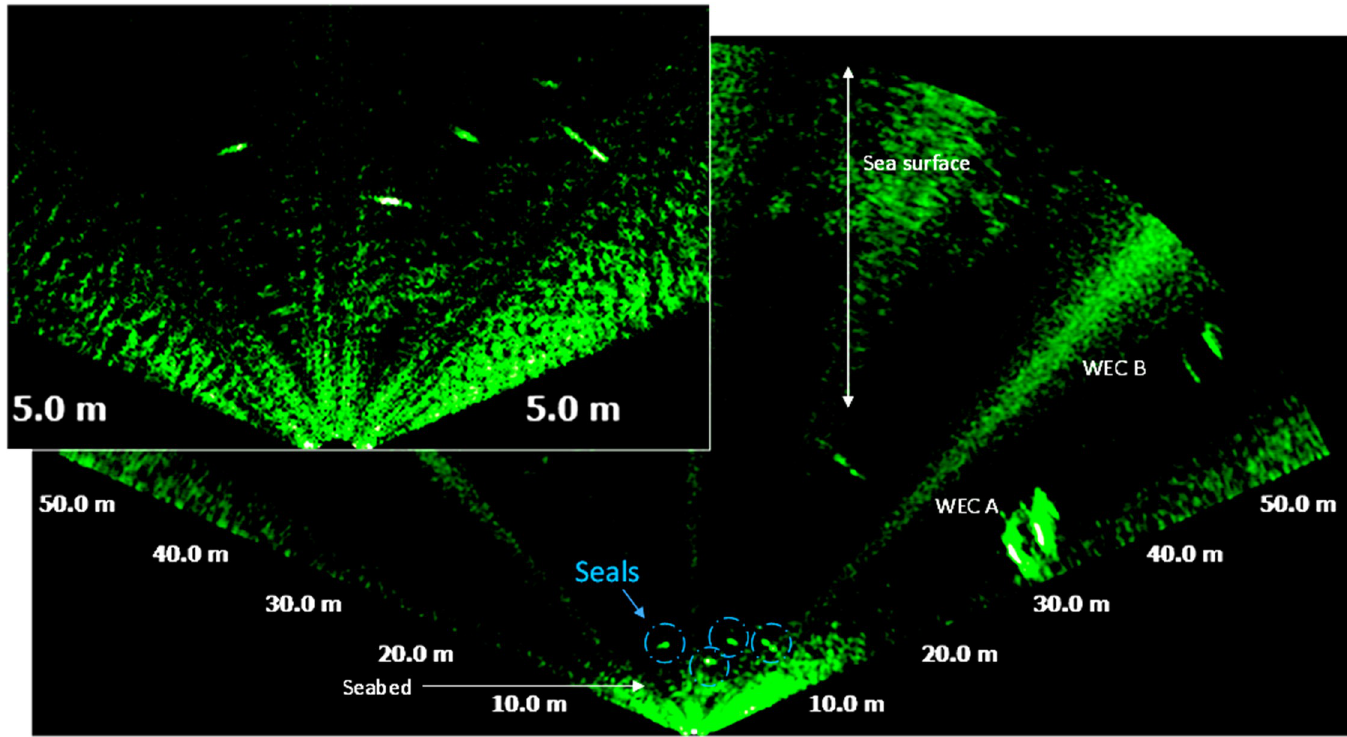
Fig 8. Acoustic image acquired on 26/08/16 at 09:20 UTC showing a group of four seals, measuring between 1.2 m to 2 m of length, detected at 6 m to 11 m of range from MBS and at distances between 20 m and 30 m from WEC A.